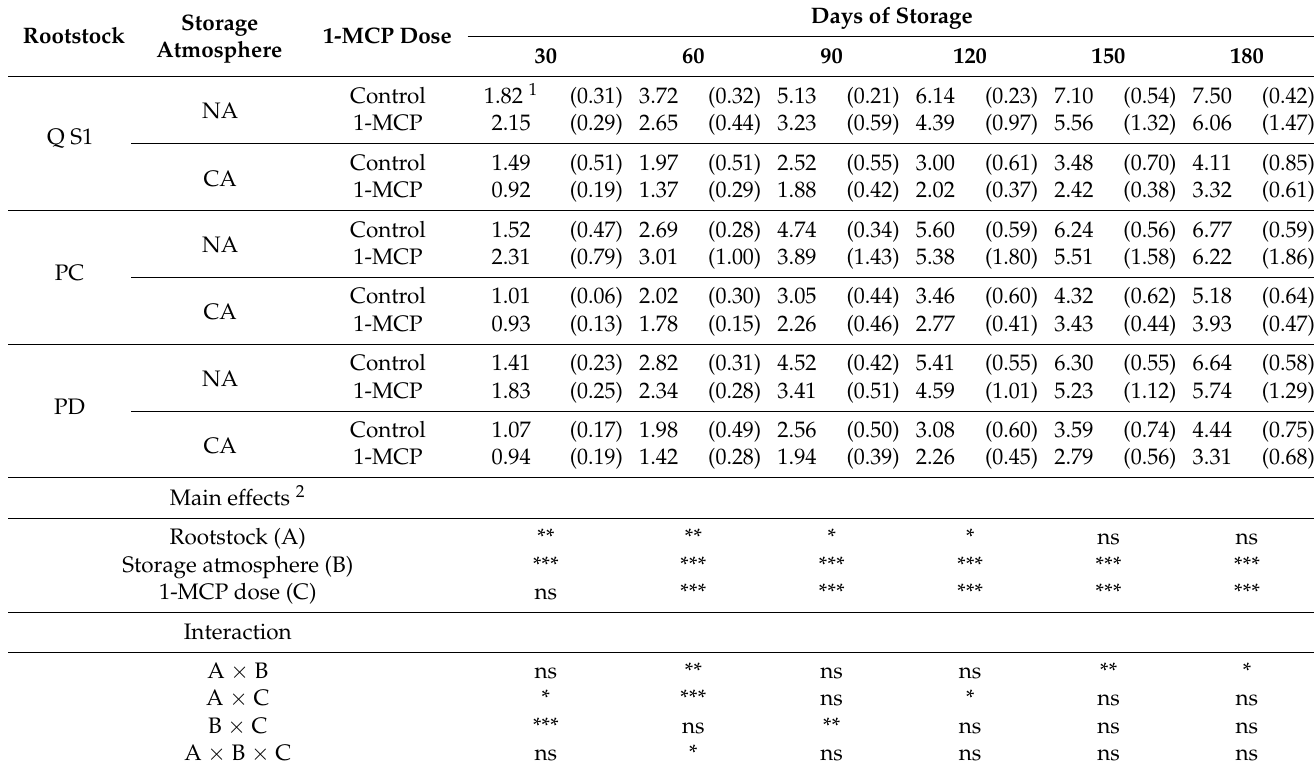
Table 2. Mass loss (%) of non-1-MCP-treated (control) and of 1-MCP-treated ‘Conference’ pears after storage in normal (NA) and controlled (CA) atmosphere in